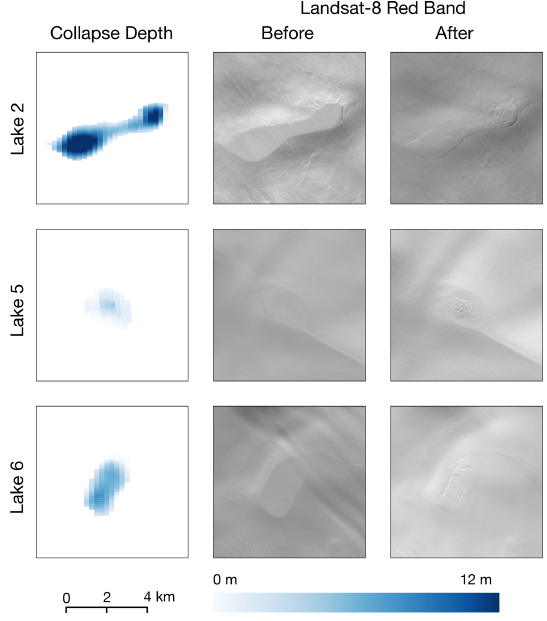
Figure 7. Elevation difference results of the photoclinometry anal- ysis beside the before and after images (Landsat 8 red band, B4) to illustrate the visible physical changes to the lake lid before and after drainage. The first column of images shows the vertical eleva- tion drop of each pixel calculated by interpolating and differencing the pre- and post-drainage topography.